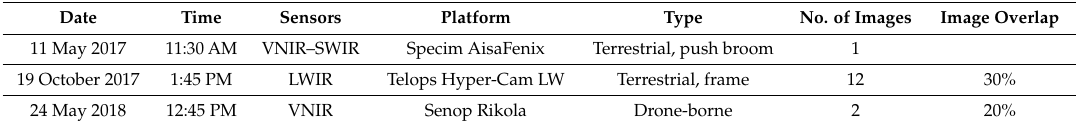
Table 1. Overview of hyperspectral datasets used in this study. Abbreviations: VNIR—visible to near-infrared; SWIR—shortwave infrared; LWIR—longwave infrared.